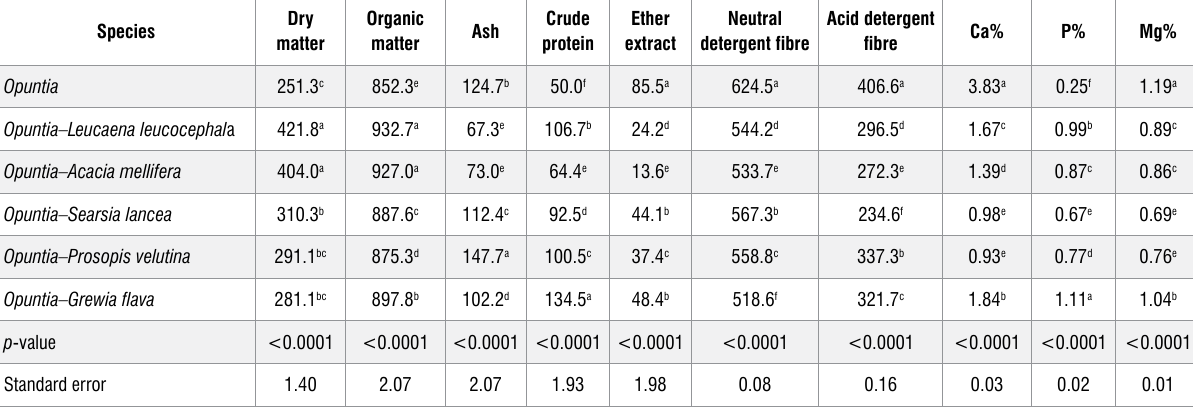
Table 2: Nutritional composition (g/kg dry matter, unless otherwise stated) of the silages used in the experiment Species